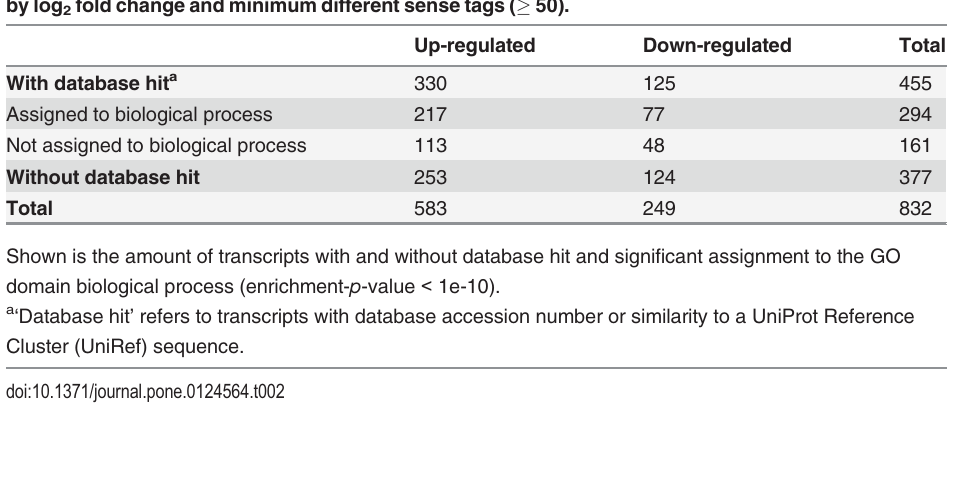
(Table S9 in S1 File). Profiling the MACE dataset revealed three potential reference genes: the